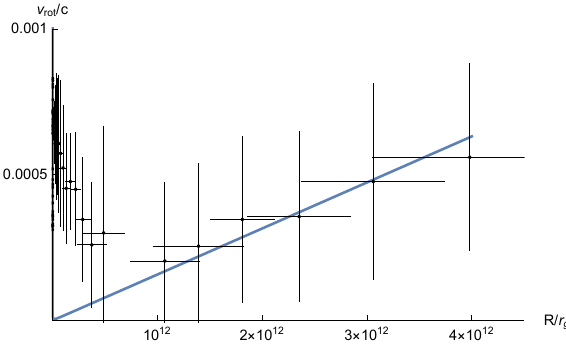
Figure 4. The rotational curve for the eicheon parameters ρ 1 = 100 M 2 p r − 2 g , R i = 1.0001 r g and